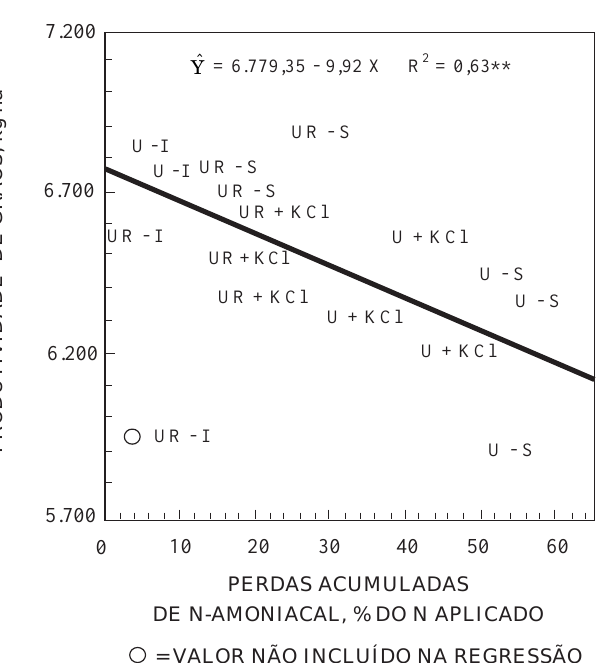
Figura 3. Efeito do N-volatilizado das fontes uréia e uran aplicadas à superfície e incorporadas na produtividade do milho sob sistema plantio direto. U-S = uréia superficial; U-I = uréia incorporada; UR-S = uran superficial; UR-I = uran incorporado; U-KCl = uréia superficial + KCl e UR-KCl = uran superficial +